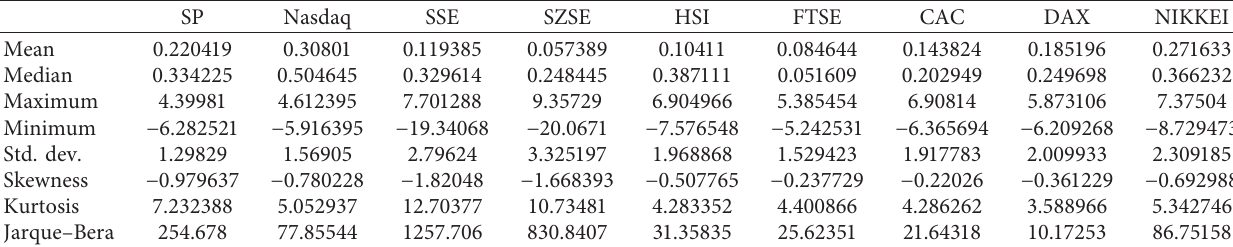
Table 1: Descriptive statistics.